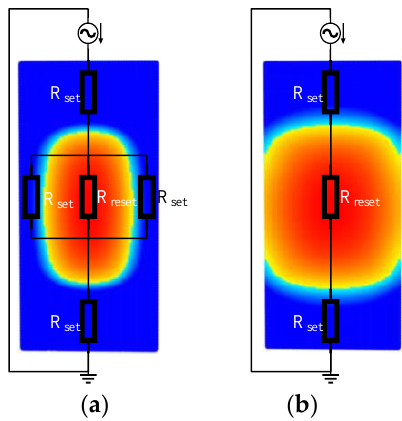
Figure 7. Amorphized regions and equivalent circuit models of GST film with different input current pulses: ( a ) 𝐼 reset = 0.96 mA; ( b ) 𝐼 reset = 0.1095 mA.